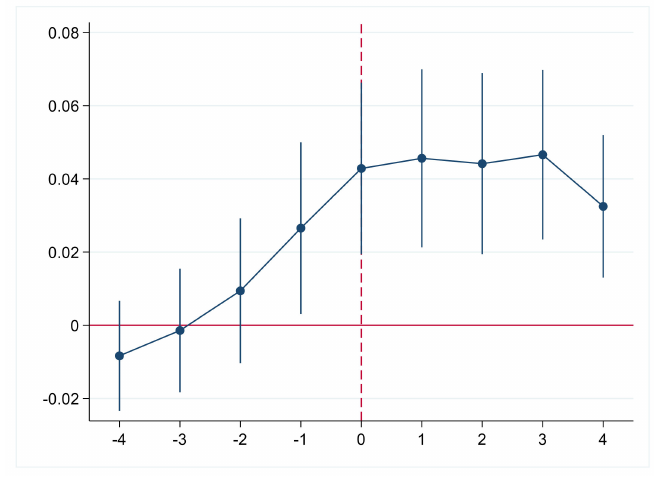
Figure 1. Parallel trend test.